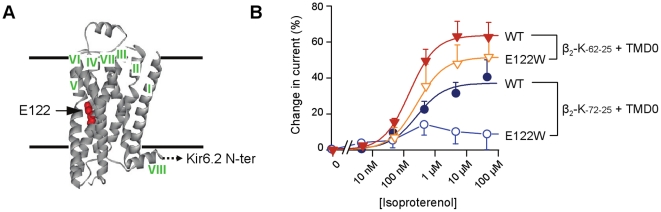
The stabilizing mutation E122 W weakens agonist-induced channel responses.(A) Location of Glu122 (in red) in the β2-adrenergic receptor structure. (B) Concentration-effect curves of isoproterenol on β2-K-62-25 and β2-K-72-25, unmodified (WT) and harboring mutation E122 W (all co-expressed with TMD0). Values are average of 5–14 measurements. Hill equation fits, represented as smooth lines, yielded EC50 of 149 nM, 247 nM, and 288 nM for β2-K-62-25, β2(E122 W)-K-62-25, and β2-K-72-25, respectively. h was 1.07, 1, and 1.18.